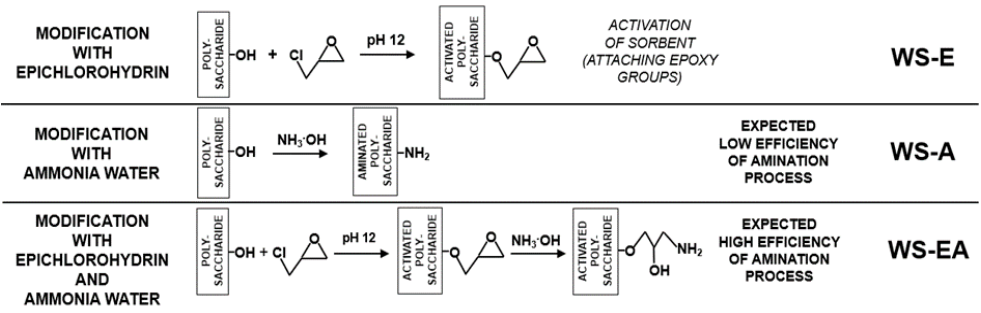
Figure 1. The scheme of WS-A, WS-E, and WS-EA preparation.